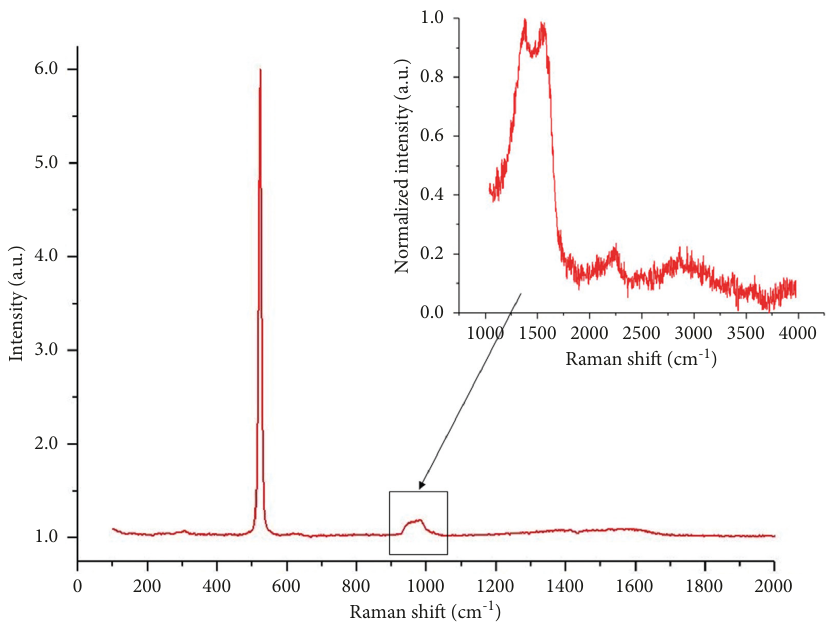
Figure 2: Raman spectra of irradiated PC doped with carbon.